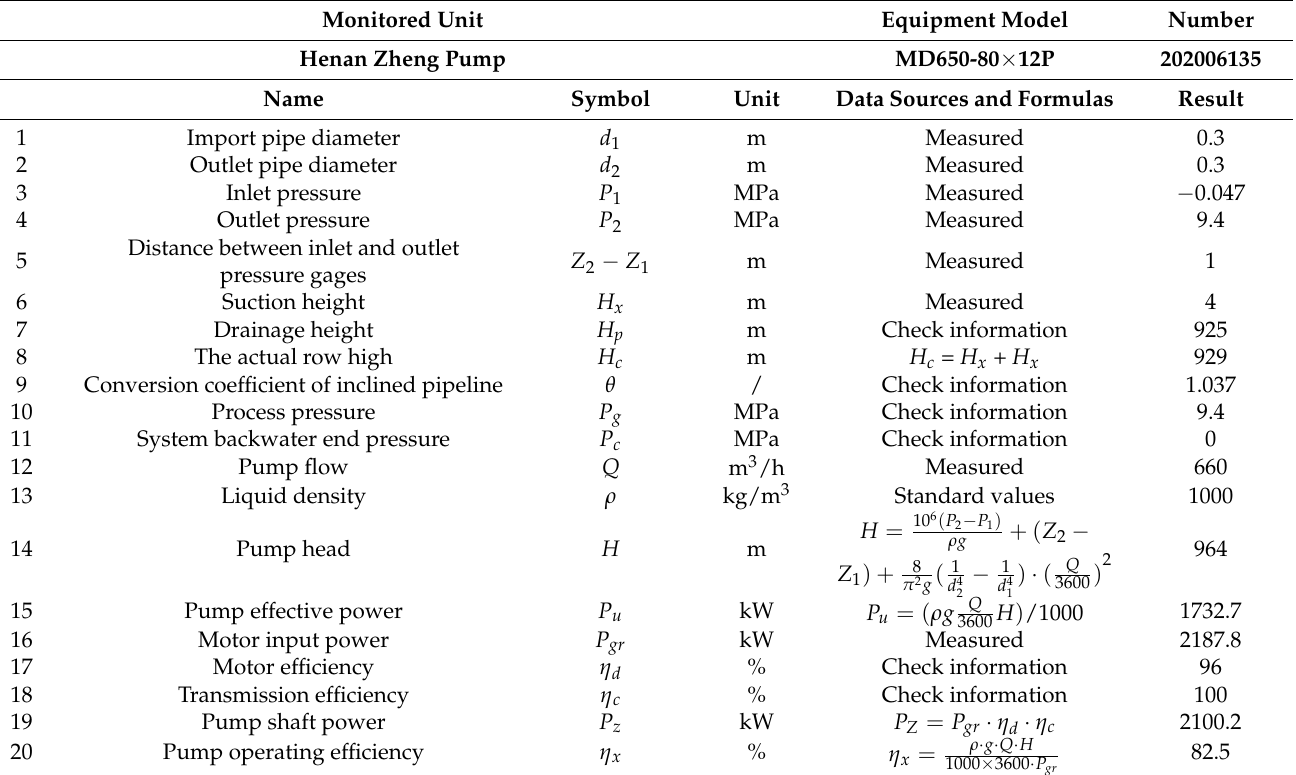
Table 4. Industrial test results of MD650-80 × 12P self-balancing multistage